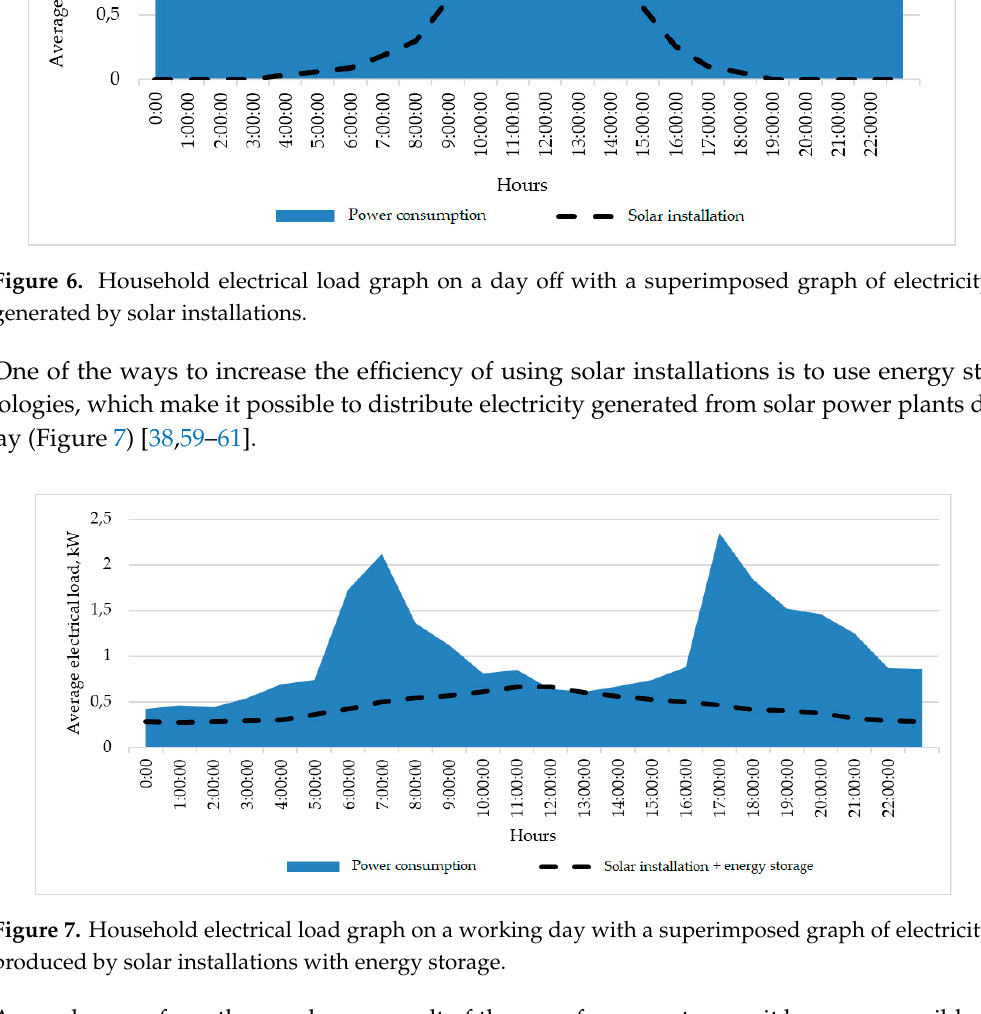
Figure 7. Household electrical load graph on a working day with a superimposed graph of electricity produced by solar installations with energy storage.